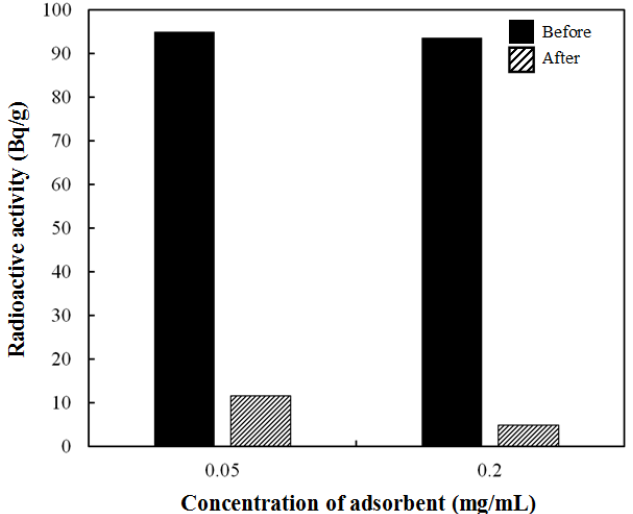
Figure 6. Removal efficiency of the radioactive cesium ( 137 Cs) using Prussian blue-coated PDDA@Iron